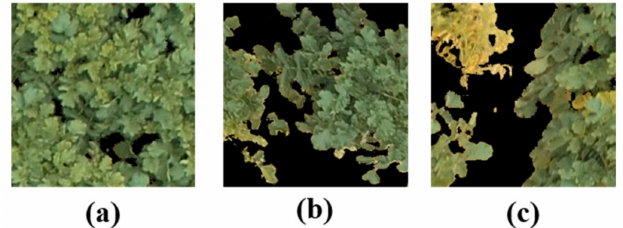
Figure 11. Wilt disease severity analysis for extracted radish regions (scaled up to 100% from the original image). ( a ) Healthy radish regions, ( b ) light disease regions, and ( c ) serious disease